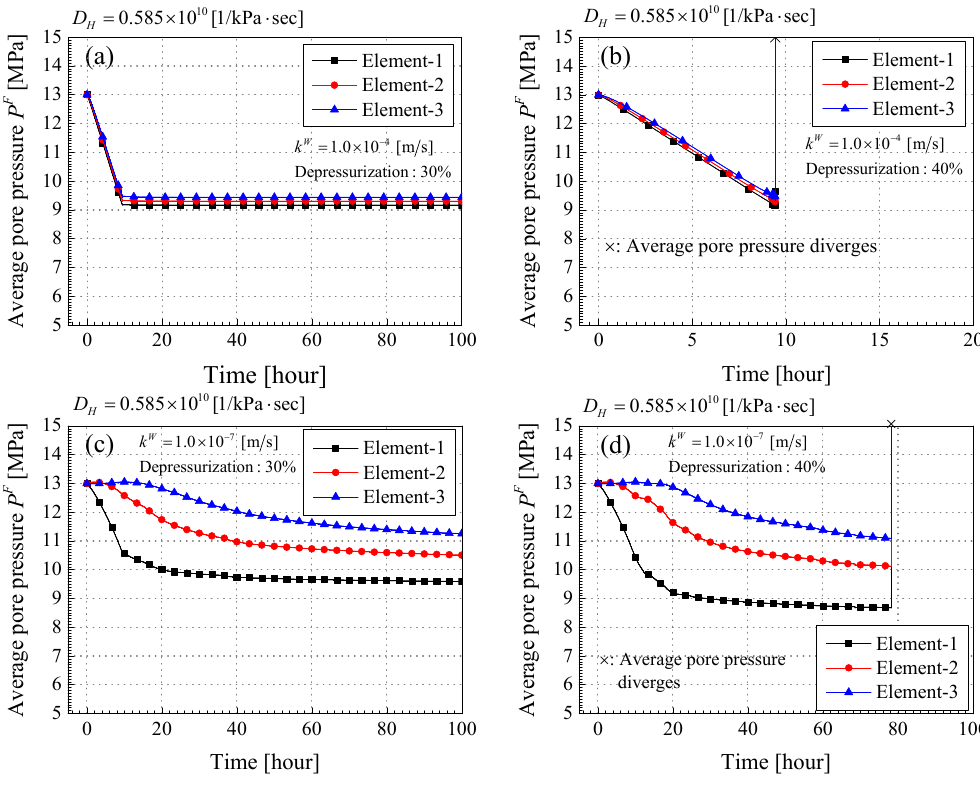
Figure 10. Time profiles of the average pore pressure P F (MPa). ( a ) Case-4-30; ( b ) Case-4-40; ( c ) Case-7-30; ( d ) Case-7-40.